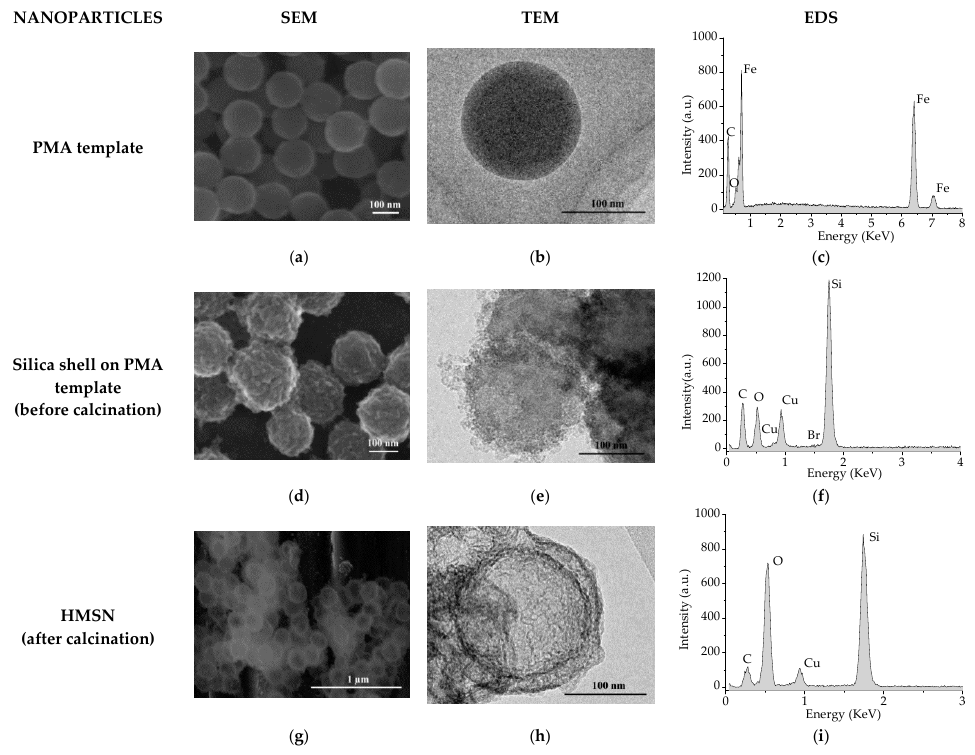
Figure 2. SEM and TEM images and EDS spectrums obtained: On PMA templates ( a – c ); on particles before calcination ( d – f, ); and after calcination ( g – i ), respectively.